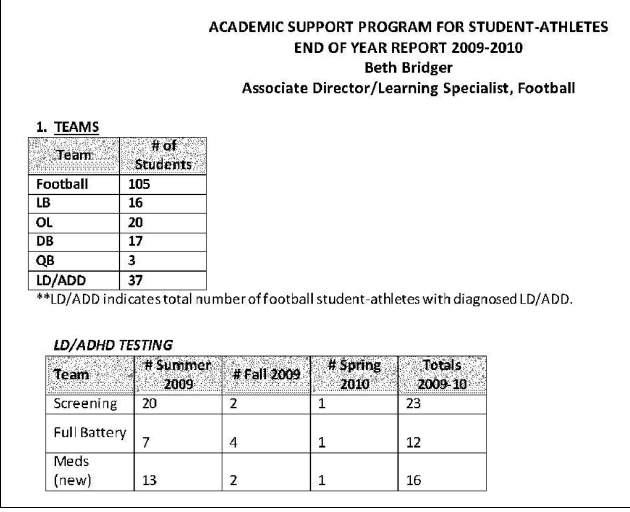
Figure 2: UNC Learning Specialist’s 2007-2008 End-of-Year Report Detailing Football Team LD/ADHD Incidence and Medication Prescription Rates